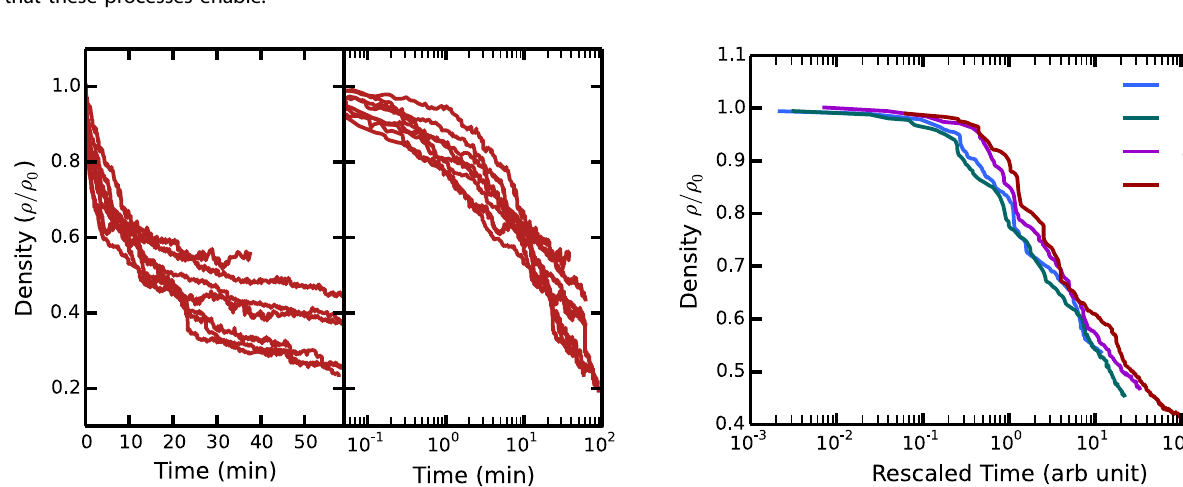
Fig. 3 Qualitative evolution of dislocations during static recovery of a microstructure with initial density 8 x 10 14 m − 2 when promptly heated to 500 C. The density drops by annihilation of closely spaced dipoles, formation or elimination of junctions by climb, and the glide that these processes enable.